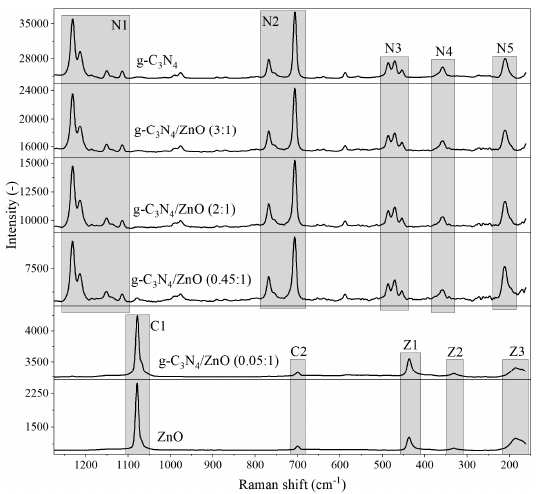
Figure 5. Raman spectra of ZnO, g-C 3 N 4 , and g-C 3 N 4 /ZnO.